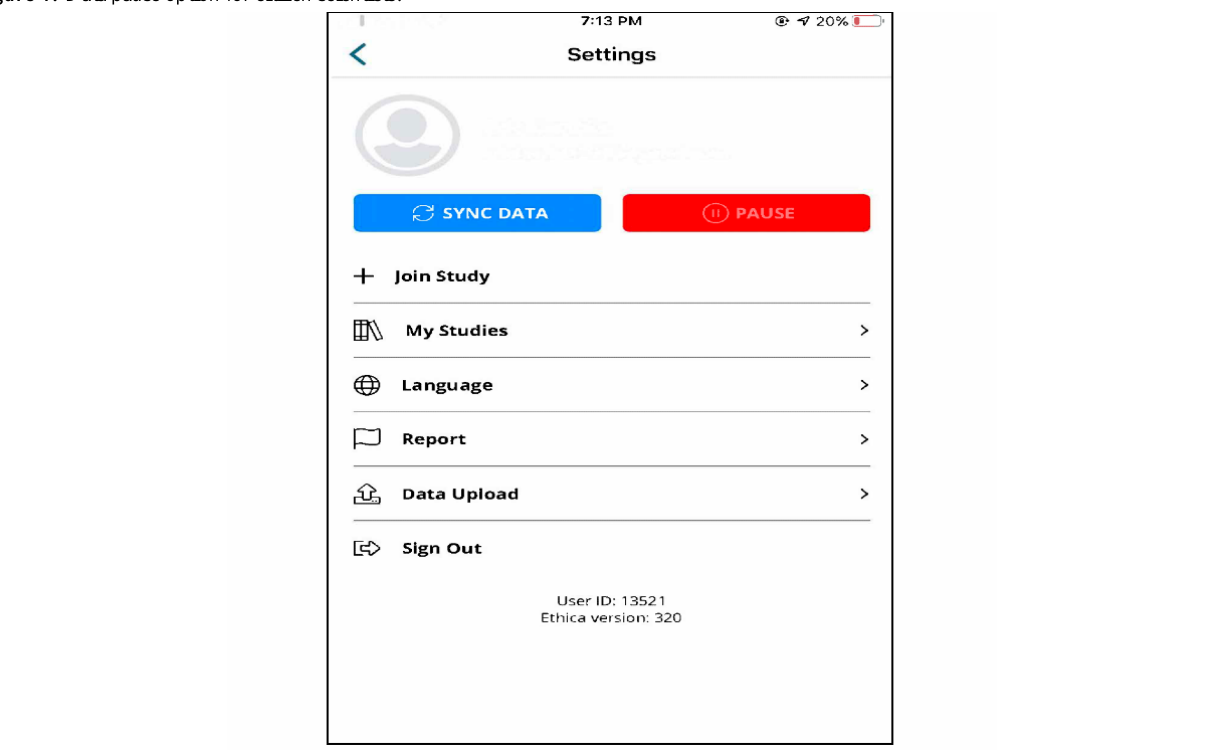
Figure 4. Data pause option for citizen scientists.